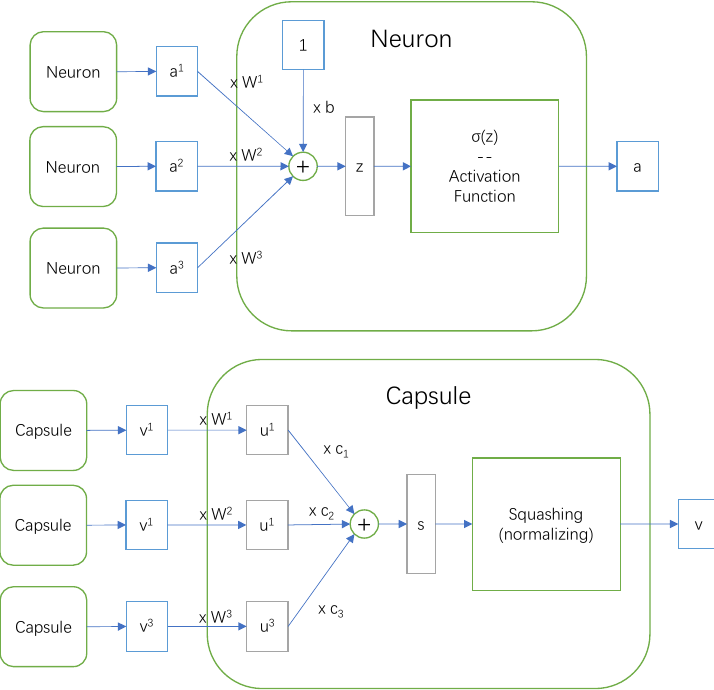
Figure 5. Structure of a neuron and a capsule.